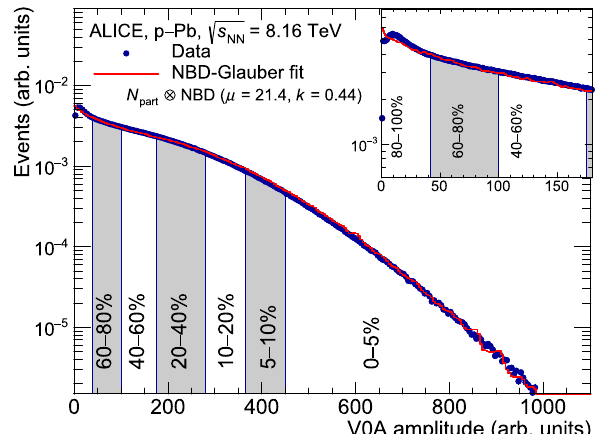
Fig. 1 Distribution of the sum of amplitudes in V0A (Pb-going side) and the NBD-Glauber fit in red. Centrality classes are indicated by vertical lines and the inset shows the most peripheral events in more detail